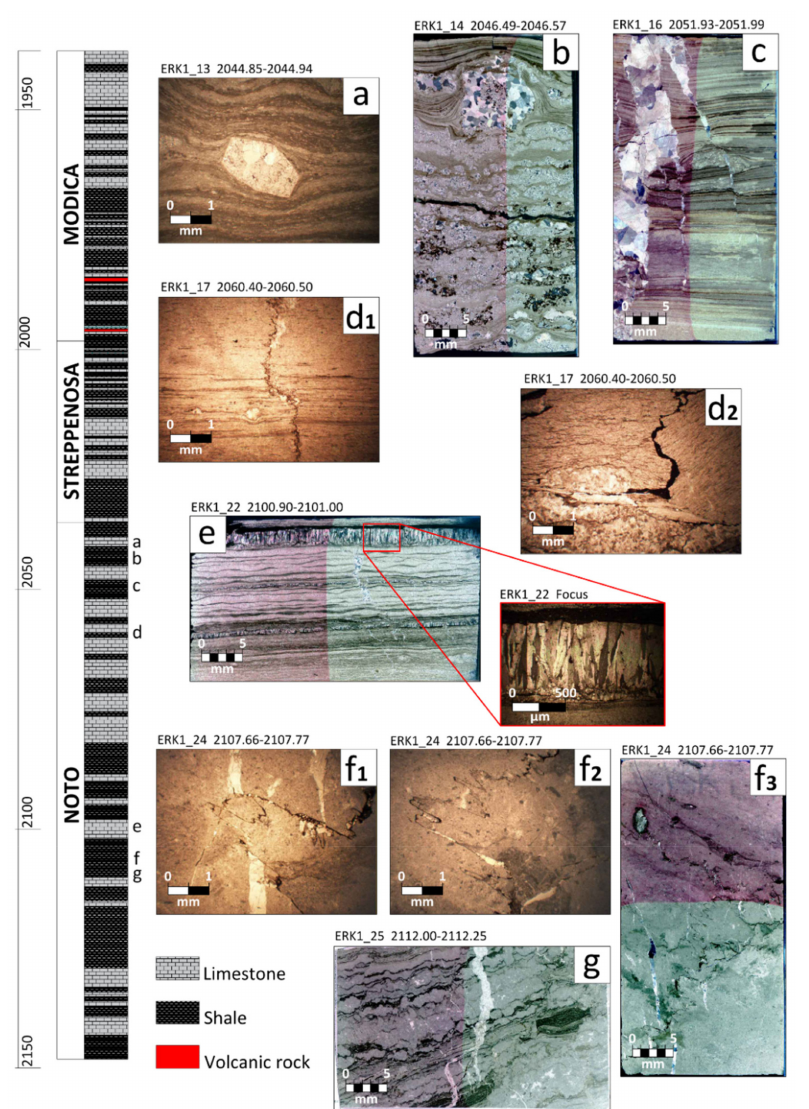
Figure 5. ( a – g ) Main microfacies and associated sedimentary, diagenetic and tectonic structures described in thin section. Vertical axis unit is in meters. ( a ) (ERK1_13): plane-polarized light photomicrograph showing stromatolite laminae and polycrystalline pseudomorph after gypsum; ( b ) (ERK1_14): crossed nicols thin section scan showing stromatolites convoluted laminae with interspersed polycrystalline calcite (probably pseudomorphs after gypsum) bitumen impregnated; ( c ) (ERK1_16): crossed nicols thin section scan showing micritic brown algal mat laminae alternated with light brown (sparite) laminae. Micro-extensional faults offsetting laminae, big veins filled with calcite; ( d 1 ) (ERK1_17) plane polarized light microphoto showing a tectonic stylolite cutting the laminae; ( d 2 ) (ERK1_17): plane polarized light microphoto showing a sub-vertical fracture filled with bitumen and a load stylolite parallel to the bedding; ( e ) (ERK1_22): crossed nicols thin section scan showing a laminite formed by microbial mats, micritic and microcrystalline layers, calcite veins, and pseudomorphs after gypsum; focus: detail of swallow-tail geminated gypsum layers; ( f 1 ) (ERK1_24): plane polarized light photomicrograph showing cross-cutting relationship between tectonic stylolites and calcite veins; ( f 2 ) (ERK1_24): plane-polarized light photomicrograph showing a tectonic stylolite partially filled with calcite and bitumen; ( f 3 ) (ERK1_24): crossed nicols thin section scan showing a mudstone-wackestone with tectonic and load stylolites partly filled with brown clay, bitumen and calcite. Organic matter is present; ( g ) (ERK1_25): plane polarized light thin section scan showing microbial algal mat rich layers alternating with carbonate (sparite) rich levels (nodular-boudins), and microfractures and veins filled with